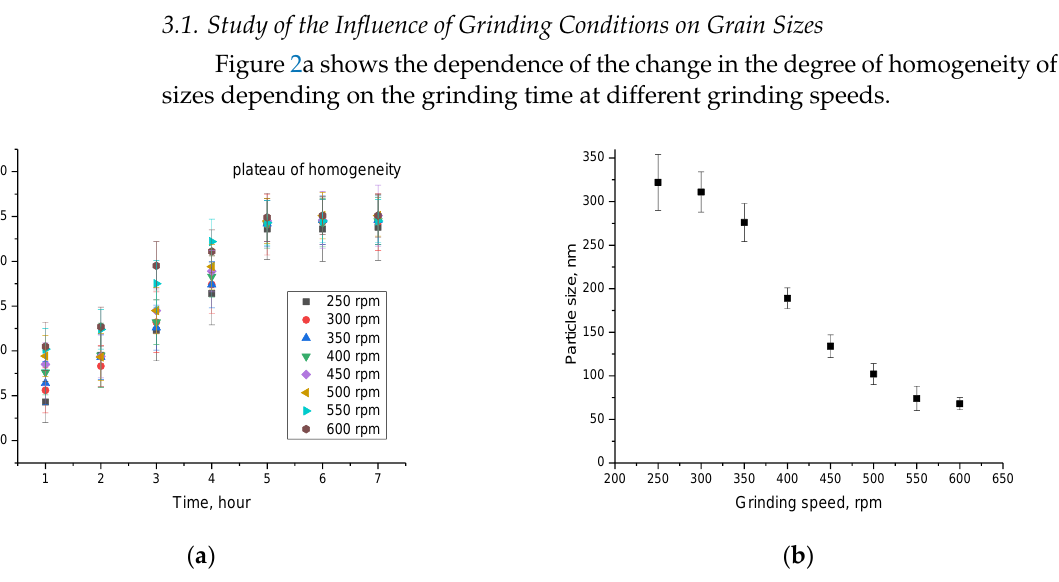
Figure 2. ( a ) Results of the homogeneity degree depending on the grinding conditions; ( b ) Results of particle size changes depending on the grinding